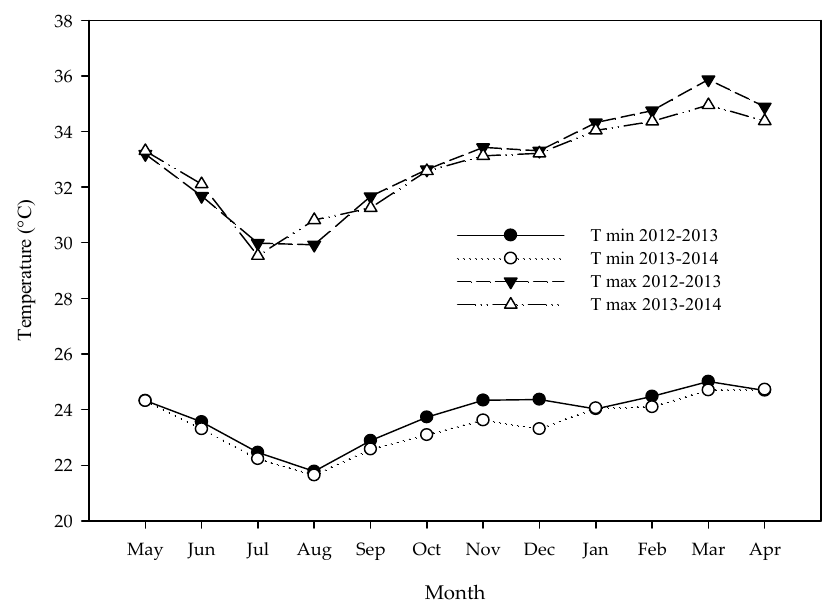
Figure 1. Dynamics of minimum and maximum temperatures over the cropping period (2012–2014) at Kpong, Ghana. The 1st and 3rd cropping cycles were from July to November while the 2nd and 4th cropping cycles spanned the period December to April.